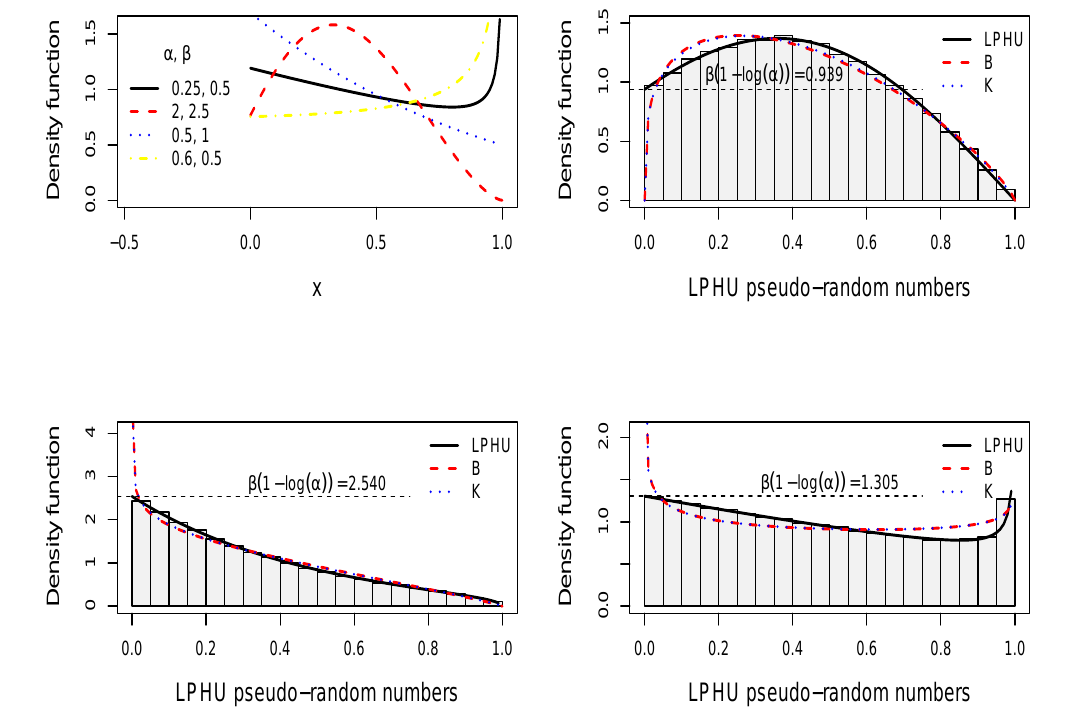
Figure 1. Top left: Some LPHU pdf curves considering different values for α and β . Top right and bottom: Histograms for three sets of 1000 pseudorandom numbers from the LPHU distribution, with ( α , β ) = (1.7, 2), (0.5, 1.5), and (0.2, 0.5), respectively, fitted with the B and K distributions via the ML